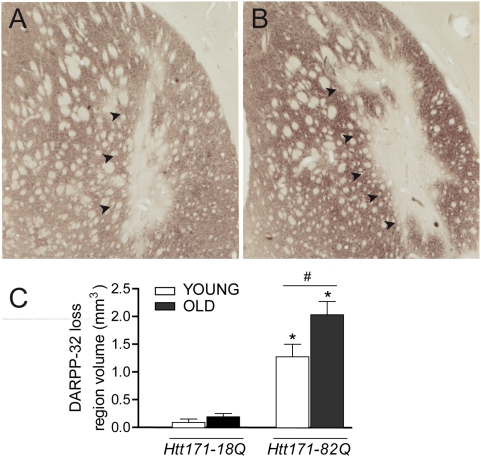
Loss of DARPP-32 induced by Htt171-82Q is more severe in old rats.Young (3 week) and old (15 month) rats received a stereotaxic injection of a mixture of lentiviral vectors (4 µl, 200 ng/µl of p24) encoding either Htt171-82Q and β-Gal or Htt171-18Q and β-Gal. Histological evaluation was carried out 12 weeks after infection using DARPP-32 immunohistochemistry. A, representative photomicrograph showing the loss of DARPP-32 in the striatum of a young rat. B, loss of DARPP-32 in the striatum of an old rat. Black arrowheads indicate the area with loss of staining. C, quantification of the volume of DARPP-32-depleted striatum. The loss measured after infection with lenti-Htt171-18Q corresponds to the mechanical damage caused by the injection needle. Note that lesions produced by Htt171-82Q are (+40%) larger in old rats. Results are expressed as mean+/−SEM. *p<0.05, Htt171-82Q vs. Htt171-18Q; #, p<0.01, young vs. old, ANOVA and Bonferroni's post hoc test.